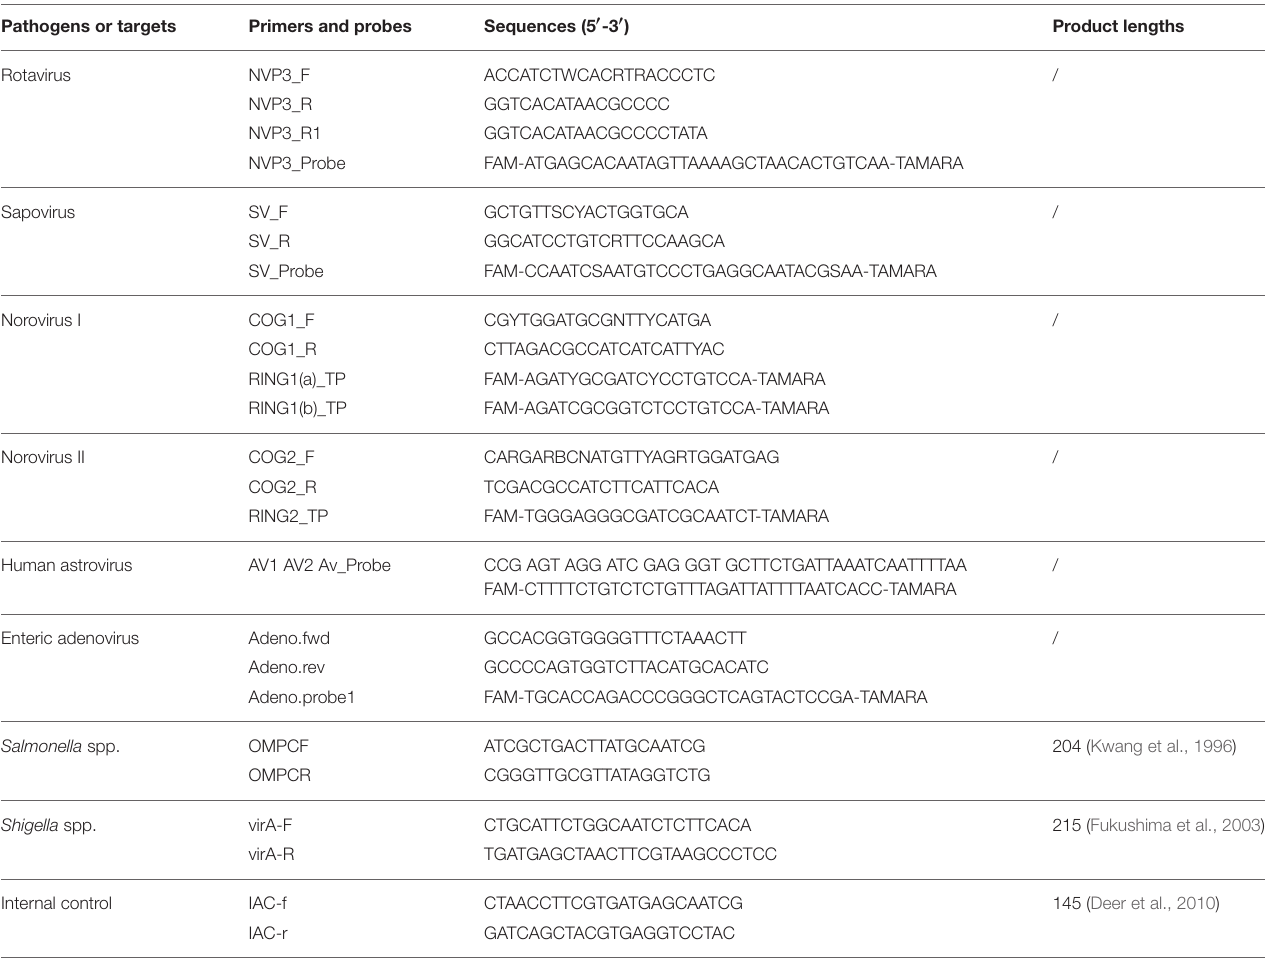
TABLE 2 | Sequences of primers and probes used in this study.